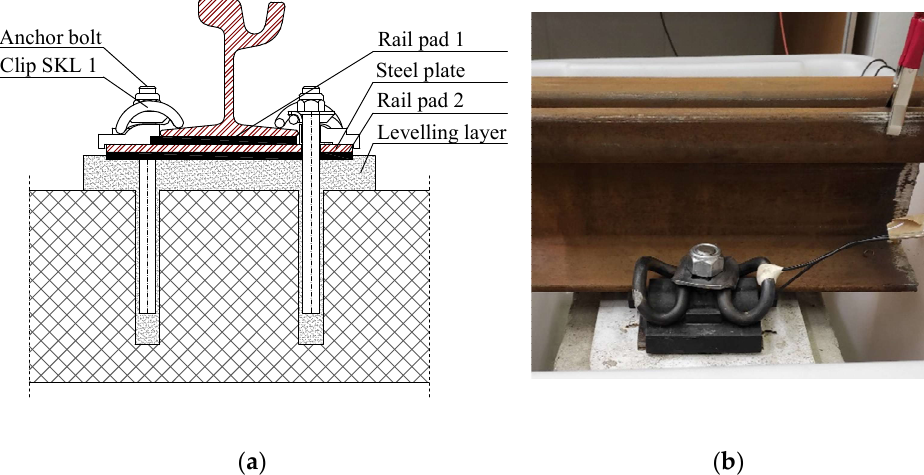
Figure 2. ( a ) Cross section of a direct fastening system. ( b ) Real-scale sample of the direct fastening system used in the tram track infrastructure in Zagreb, Croatia.